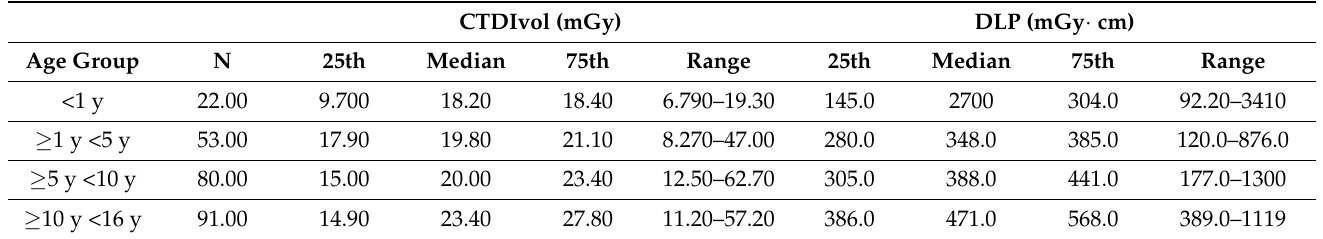
Table 2. CTDIvol and DLP values for pediatric head CT scans in Abu Dhabi, UAE, with different percentiles; “y” represents year, and “N” represents number of patients. CTDIvol (mGy) DLP (mGy ·